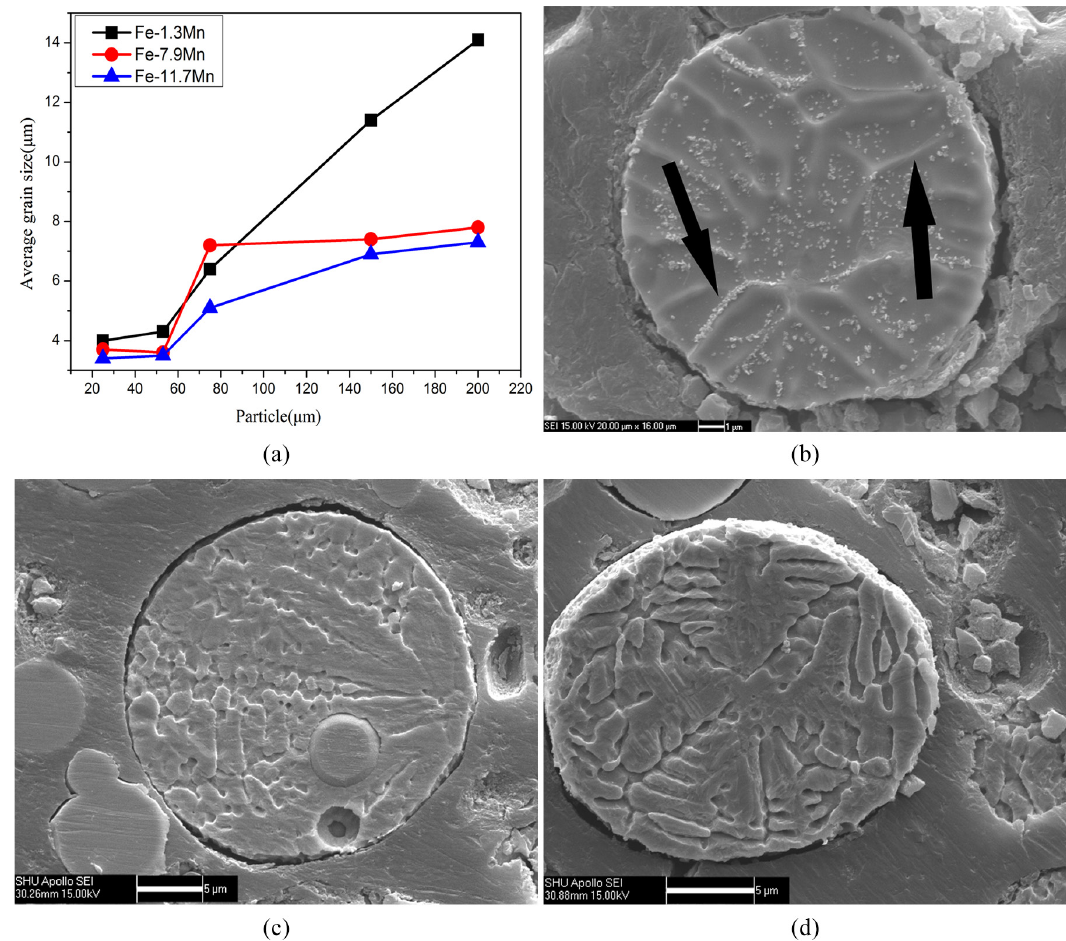
Figure 4. Structure of Fe-1.3, 7.9, 11.7Mn alloy powders: (a) Relationship between grain size and powder diameter; SEM images of (b) Fe-1.3Mn; (c) Fe-7.9Mn; (d) Fe-11.7Mn alloy powders in diameter of